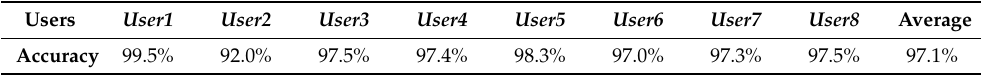
Table 8. Accuracy of the user-independent case.